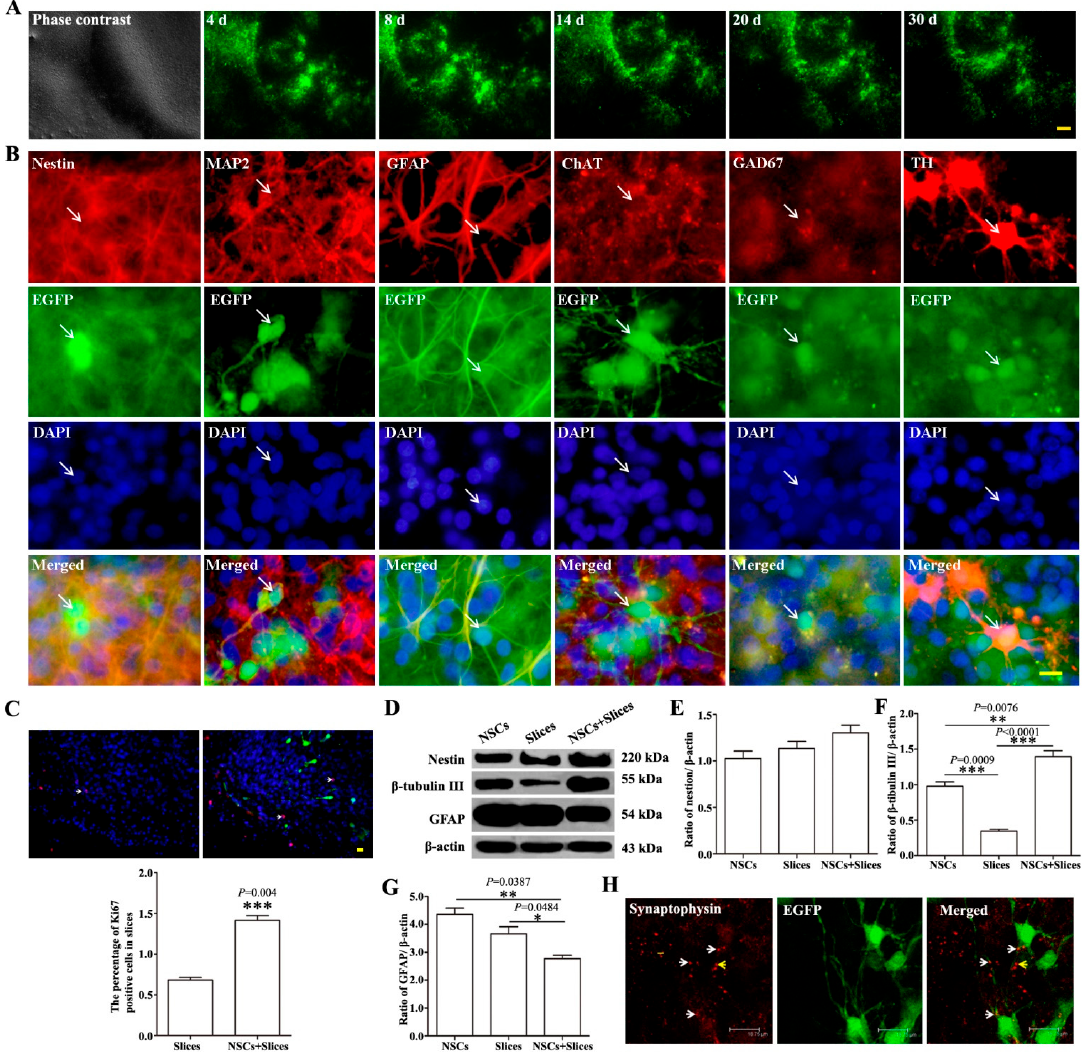
Figure 1. The survival and differentiation of transplanted NSCs on organotypic brain slices under normal conditions. ( A ): Transplanted NSCs survived on host brain slices for more than 30 days. Scalar bar = 500 μ m. ( B ): Transplanted NSCs on host brain slices differentiated to astrocytes and different types of neurons. White arrows: the double stained cells. Scalar bar= 20 μ m. ( C ): The number of Ki-67-positive cells in brain slices with NSCs transplantation was significantly higher than in the slices without transplantation. White arrows: the double stained cells. Scalar bar = 20 μ m. Ki-67 was shown in red. The values are mean ± SE. *** p < 0.001, n = 5. ( D – G ): The protein levels of nestin, β -tubulin III and GFAP detected through Western blotting showed a dramatic increase in β -tubulin III and a decrease in GFAP in brain slices after NSCs transplantation. The values are mean ± SE. * p < 0.05, ** p < 0.01, *** p < 0.001, n = 5. ( H ): Potential synaptic connections between transplanted NSCs and host cells. White arrows: synaptophysin protein expressed in EGFP-positive cells; yellow arrows: synaptophysin protein expressed in host cells which very closed to EGFP-positive cells. Scalar bar = 18.75 μ m.